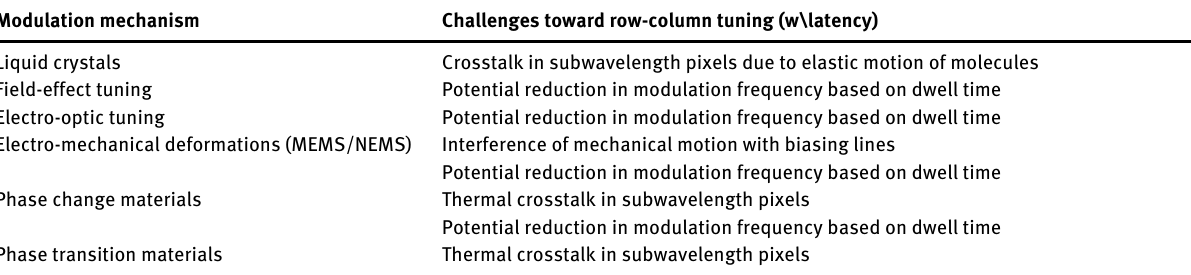
Table 3: Challenges toward the realization of a row-column tuning approach for various modulation mechanisms that rely on an electrical